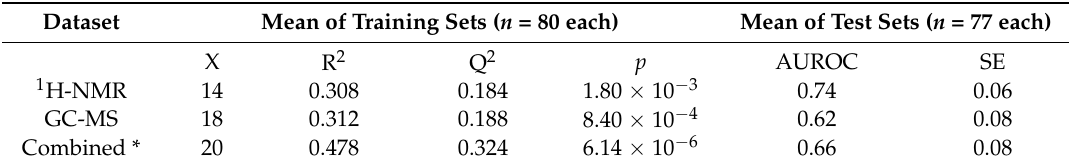
Table 2. Results of orthogonal partial least squares discriminant analysis (OPLS-DA). Dataset